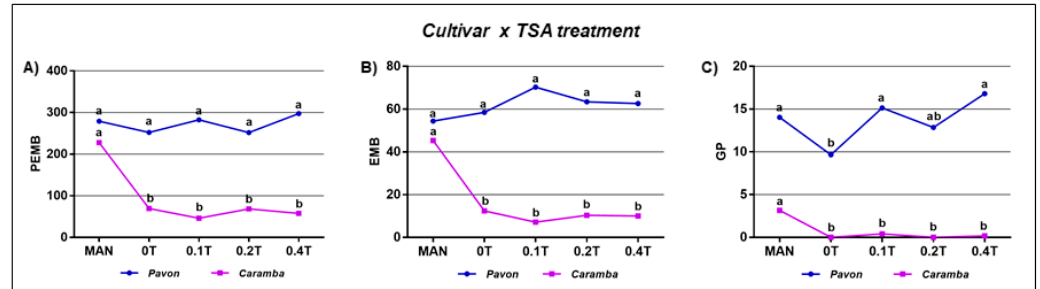
Figure 2. Microspore embryogenesis of bread wheat cvs. Pavon and Caramba after the application of different concentrations of TSA for 2 h as a unique induction treatment before culture. A) Analysis of the interaction cultivar x treatment for the variables: A) Number of proembryos (PEMB); B) Number of embryos (EMB); C) Number of green plants (GP), all per 100 anthers. Treatments with the same letter within each variable and cultivar are not significantly different ( p ˂ 0.05) according to a Duncan test. MAN = 0.7 M mannitol for 5 days at 25 °C (control cultures); 0T = 1% DMSO; 0.1T = 0.1 µM TSA; 02T = 0.2 µM TSA; 0.4T = 0.4 µM TSA.